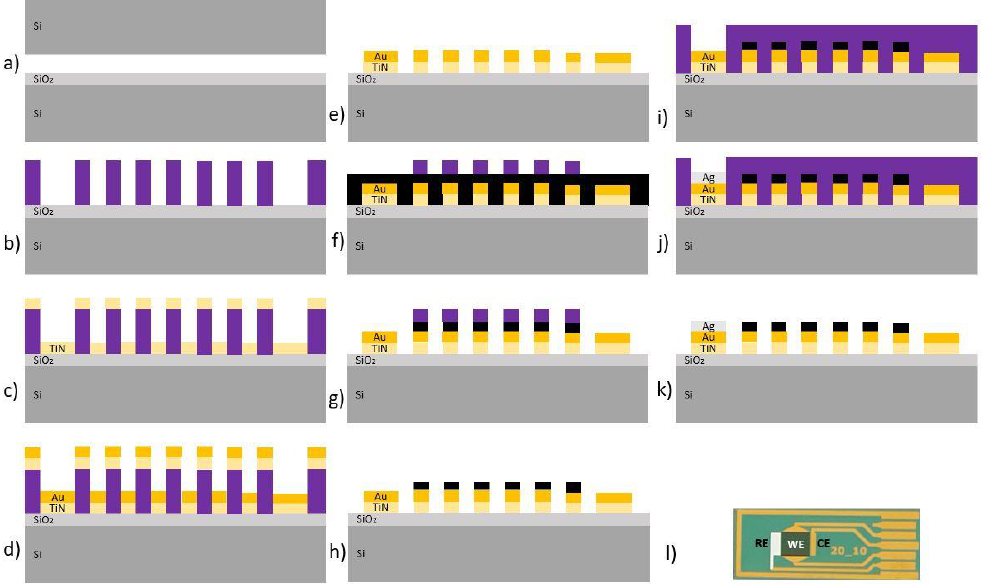
Figure 2. ( a ) Si/SiO 2 ; ( b ) M1 photolithography; ( c ) TiN film deposition; ( d ) Au deposition; ( e ) Lift- off; ( f ) VG growth; ( g ) M2 photolithography; ( h ) VG etching; ( i ) photoresist removal; ( j ) M3